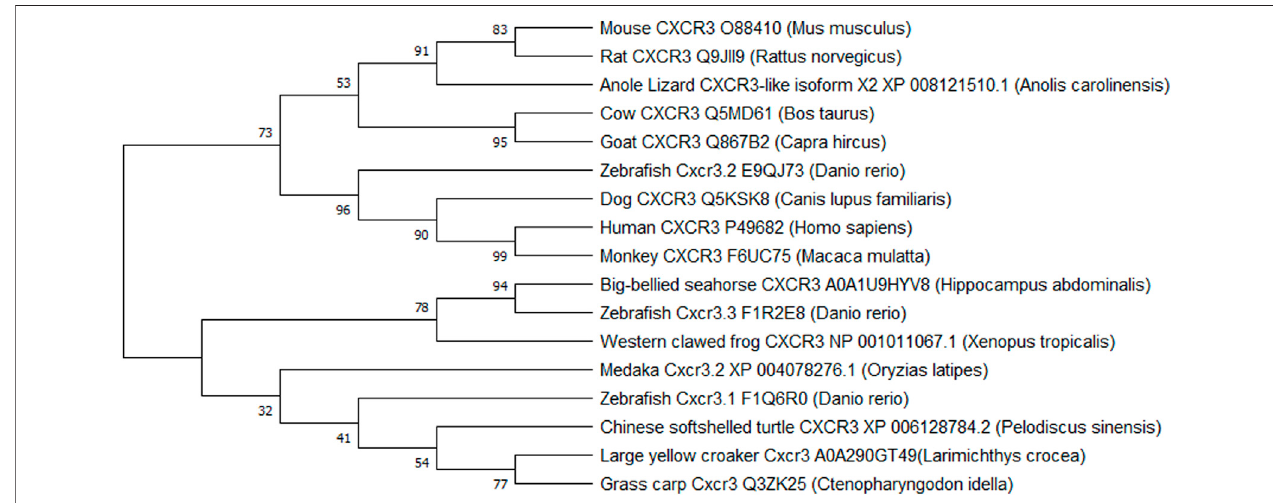
FIGURE 2 | Phylogenetic tree representing the evolution of CXCR3 and CXCR3-like genes in vertebrates. The evolutionary history was inferred by using the Maximum Likelihood method and Dayhoff matrix-based model (Dayhoff et al., 1978). Evolutionary studies were conducted in MEGA X (Kumar et al., 2018).